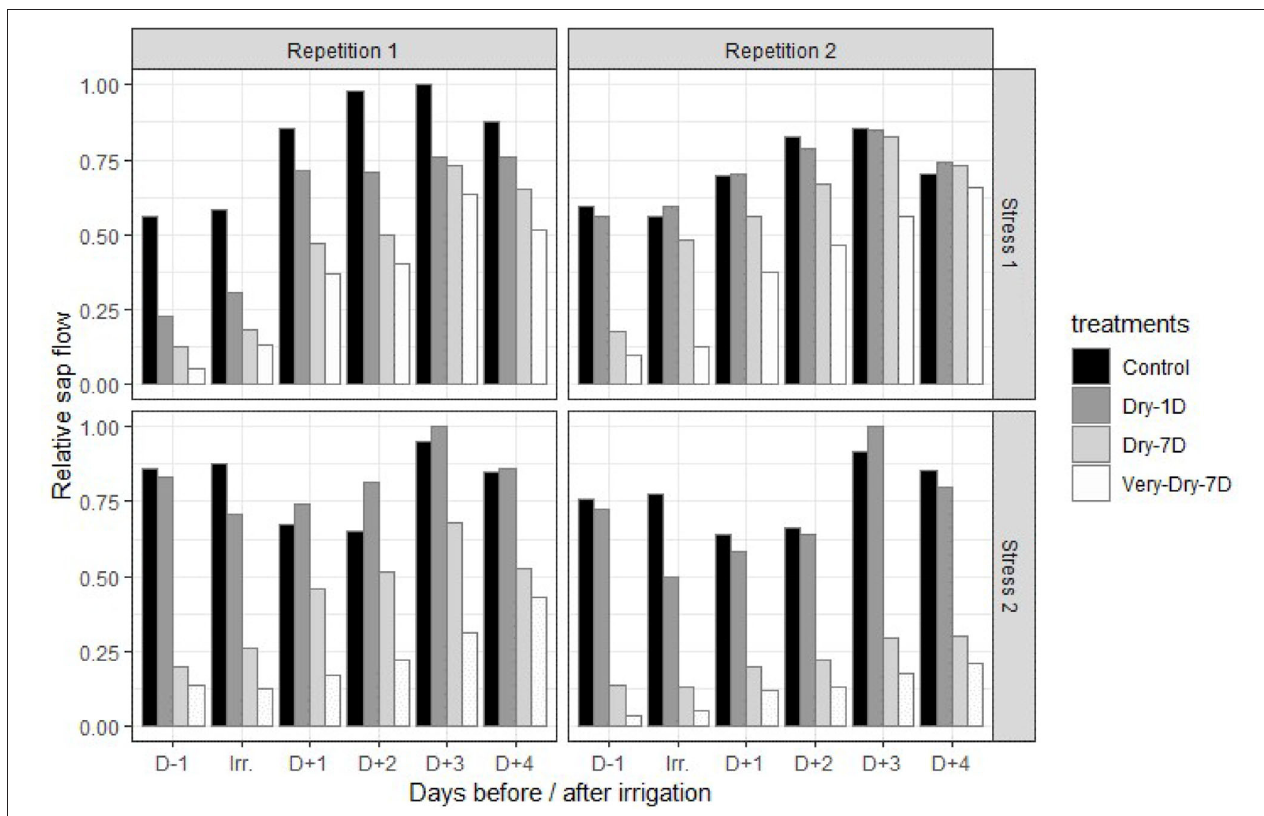
FIGURE 3 | Evolution of relative sap flow for the control, dry-1D, dry-7D, and very-dry-7D irrigation treatments over a period from the day before and up to 4 days after irrigation treatments application (summer 2019